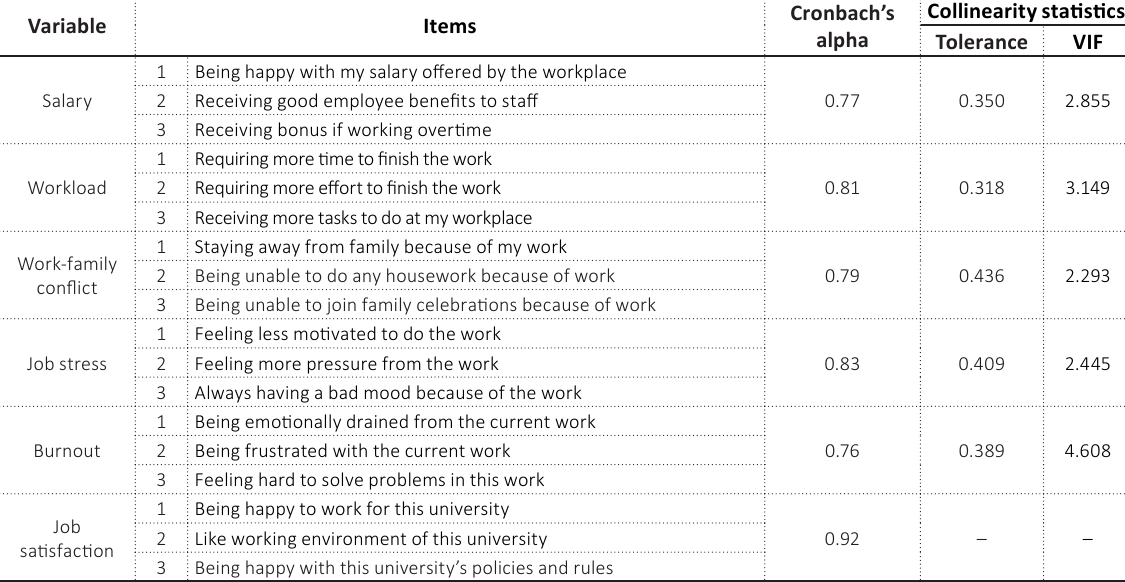
Table 1. Reliability and collinearity diagnostic